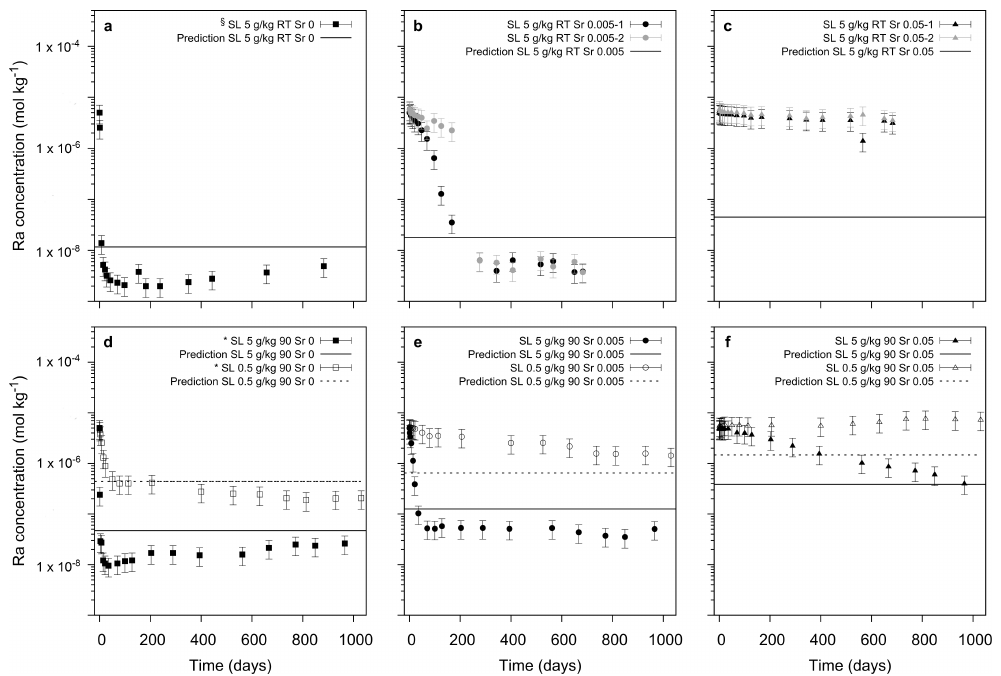
Figure 3. Temporal evolution of aqueous Ra aq concentrations at ambient conditions ( a – c ) and 90 ◦ C ( d – f ). Left column: experiments without Sr, middle column: experiments with 0.005 g/kg Sr and right column: experiments with 0.05 mol/kg Sr in the aqueous solution. The lines indicate predicted concentrations calculated by GEMS. Experimental data taken from Brandt et al., 2015 [7] marked § , experimental data from Vinograd et al., 2018b [21] marked with *.